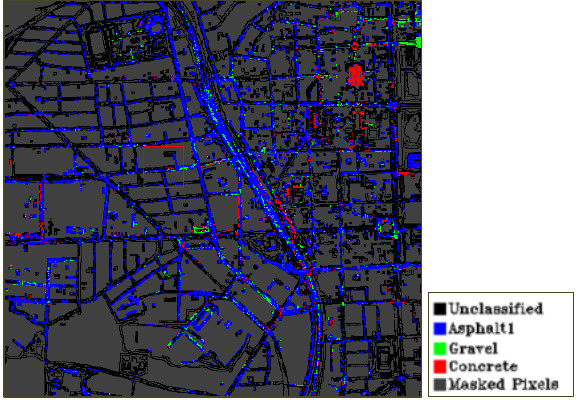
Figure 2. SAM classification using threshold of 0.08 (radians).